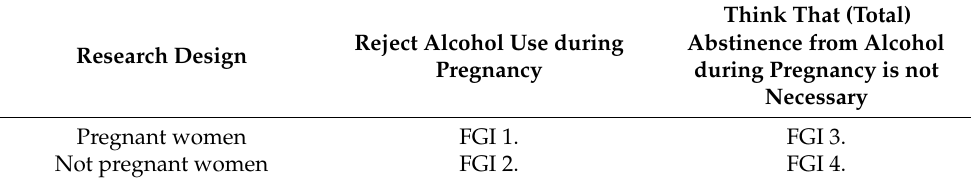
Table 1. Inclusion criteria for each focus